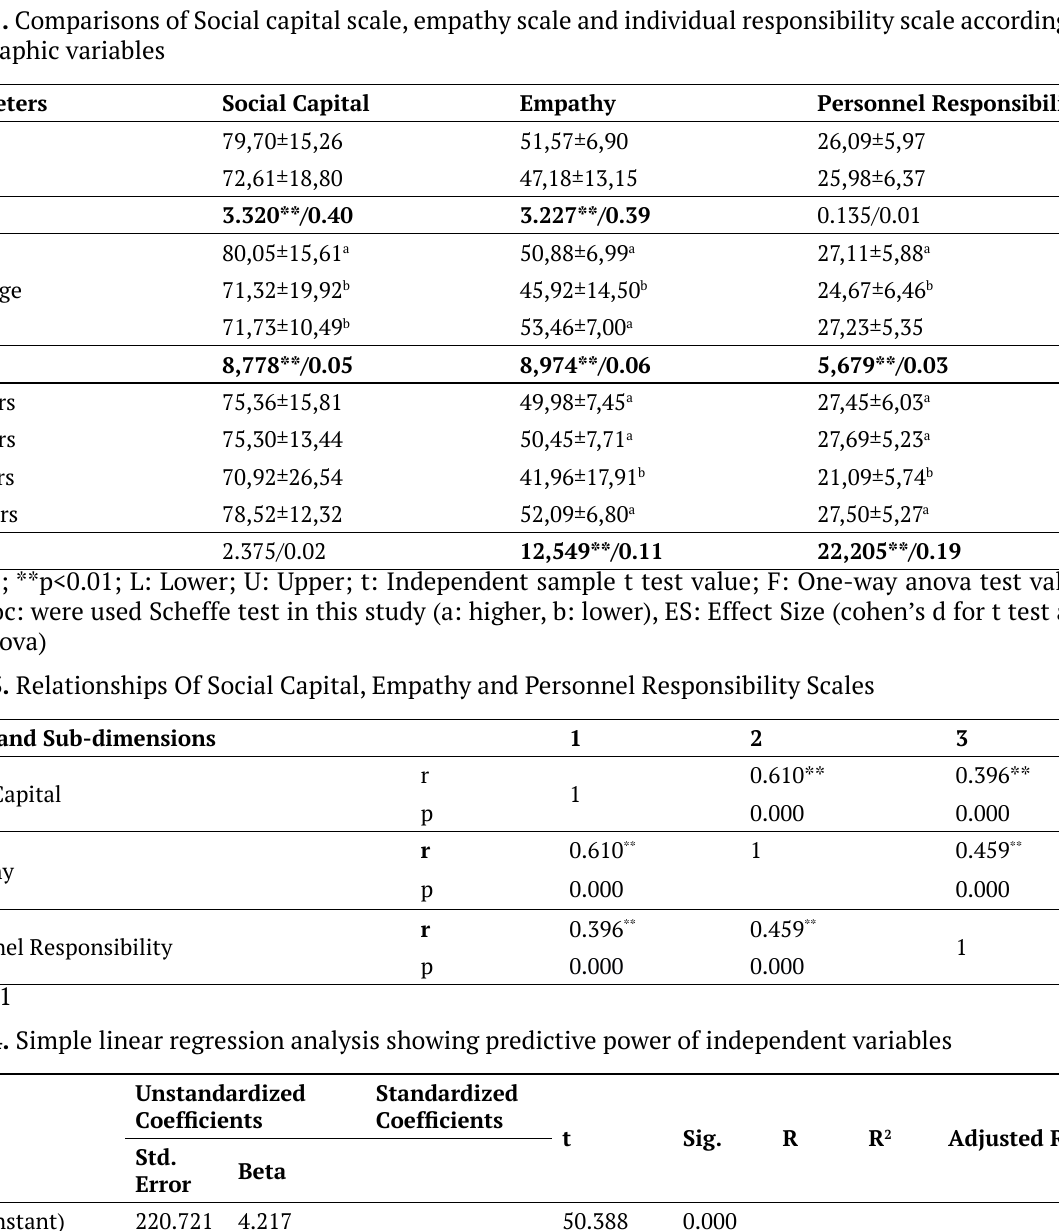
Table 2. Comparisons of Social capital scale, empathy scale and individual responsibility scale according to